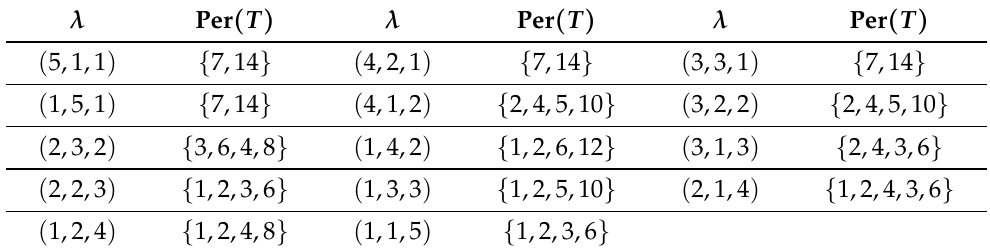
Table 6. Periods of T with m = 7.